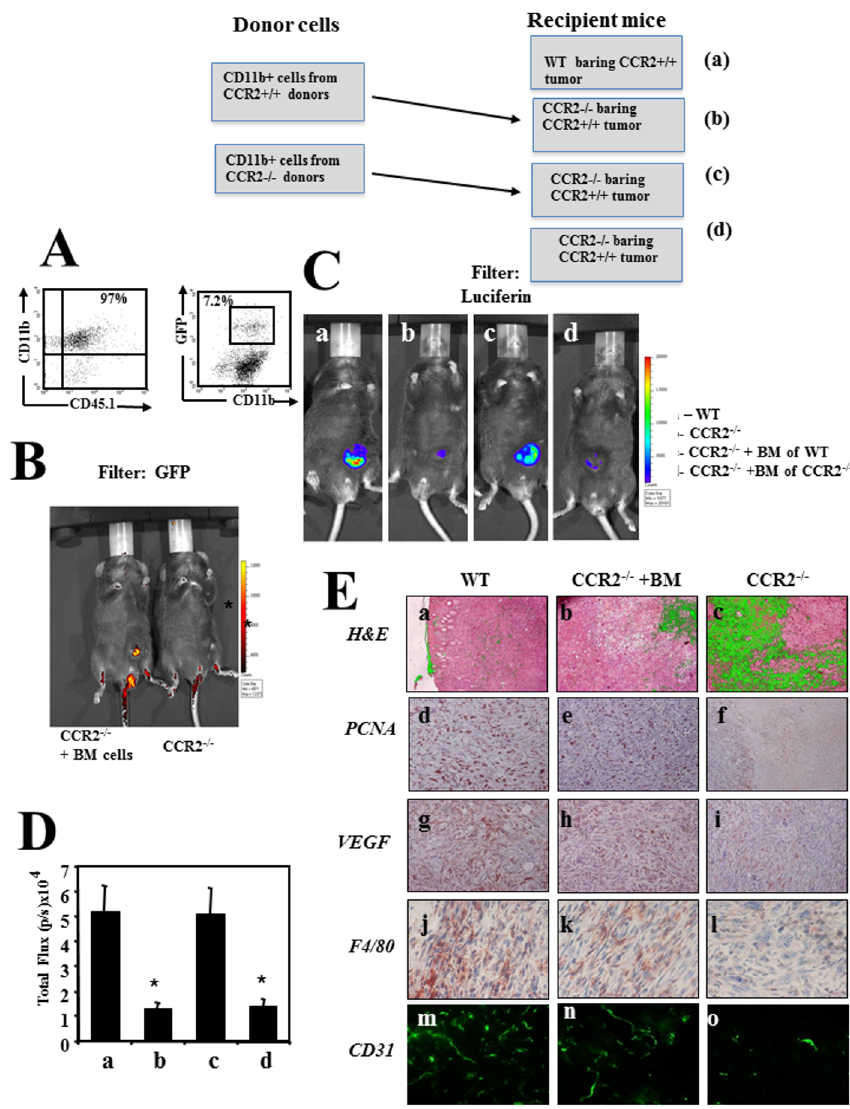
Fig 2. Bone marrow derived CD11b+CCR2+ cells are essential to support tumor development and angiogenesis. ( A ) CD11b+ BMD cells from cx3cr1gfp CCR2+ CD45.1 mice were purified (left panel), analyzed fro the relative mummer of GFP+ cells (right panel) and transferred to CCR2−/−mice bearing CCR2+ tumor ( B ) shows imaging (IVIS) of a representative mouse as recorded using a GFP filter. ( C ) Imaging (IVIS) of the primary tumor on day 60, as recorded by the IVIS camera using–luciferin filter (recording luciferase activity of the cancer cells) as follows: CCR2+/+ C57BL/6 mice (WT) (a), CCR2−/− mice (b), CCR2−/−transplanted with BM of WT mice(c) and CCR2−/−transplanted with BM of CCR2−/−mice. All photos show a representative mouse per group (1 of 6 mice). ( D ) The computerized CCCD analysis of six mice per group. Results are shown as total flux (p/s ×104) ±SE. (cid:3) Indicates p < 0.001 ( E ) Histological, Immunohistochemical and immunofluorescence analyses of primary tumors from C57BL/6 WT mice, CCR2-/- (KO) mice, and CCR2-/- (KO) mice reconstituted with BM from WT mice. Panel a-c show H&E staining, d-f show anti -PCNA staining, g-i show anti VEGF, j-l show anti F4/80, m-o show anti